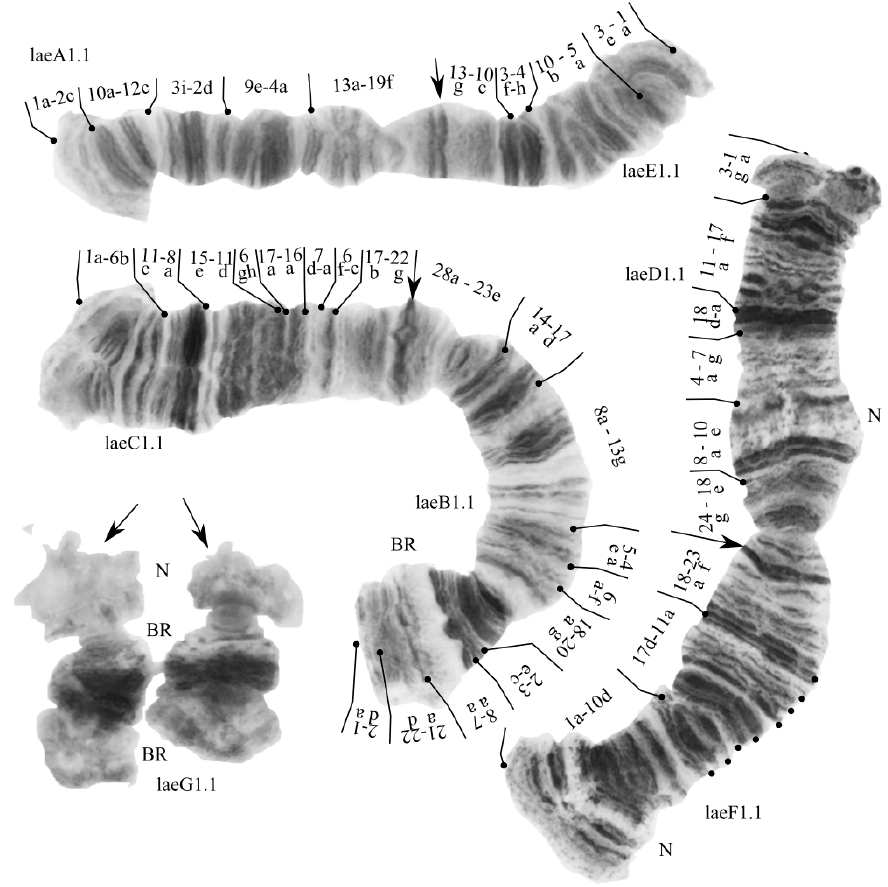
Figure 4. Karyotype of Chironomus laetus from the Yamal Peninsula, Russia. Arrows indicate centromeric bands; laeA1, laeE1, etc., genotypic combinations of banding sequences in chromosome arms; BR—Balbiani rings; N—nucleous.